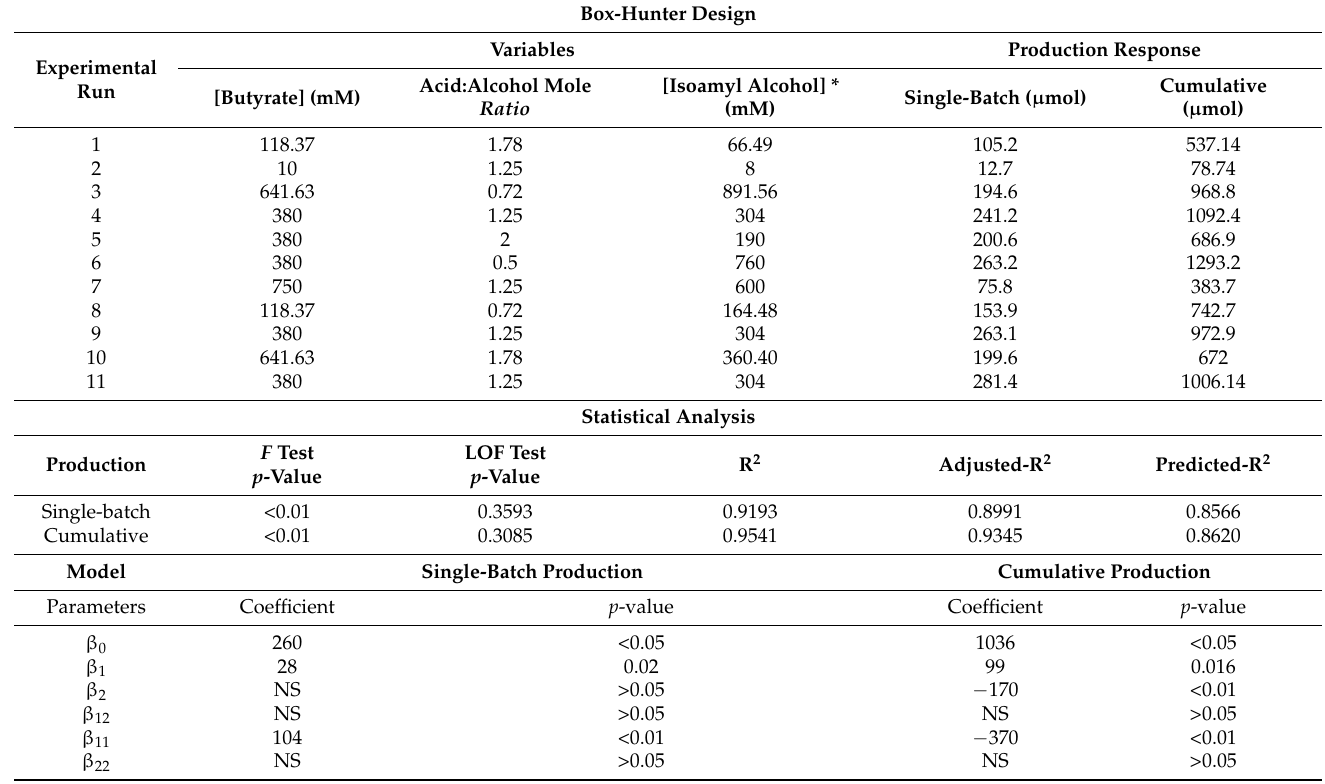
Table 1. Box-Hunter design, independent variables, response values obtained and results of the ANOVA analysis.